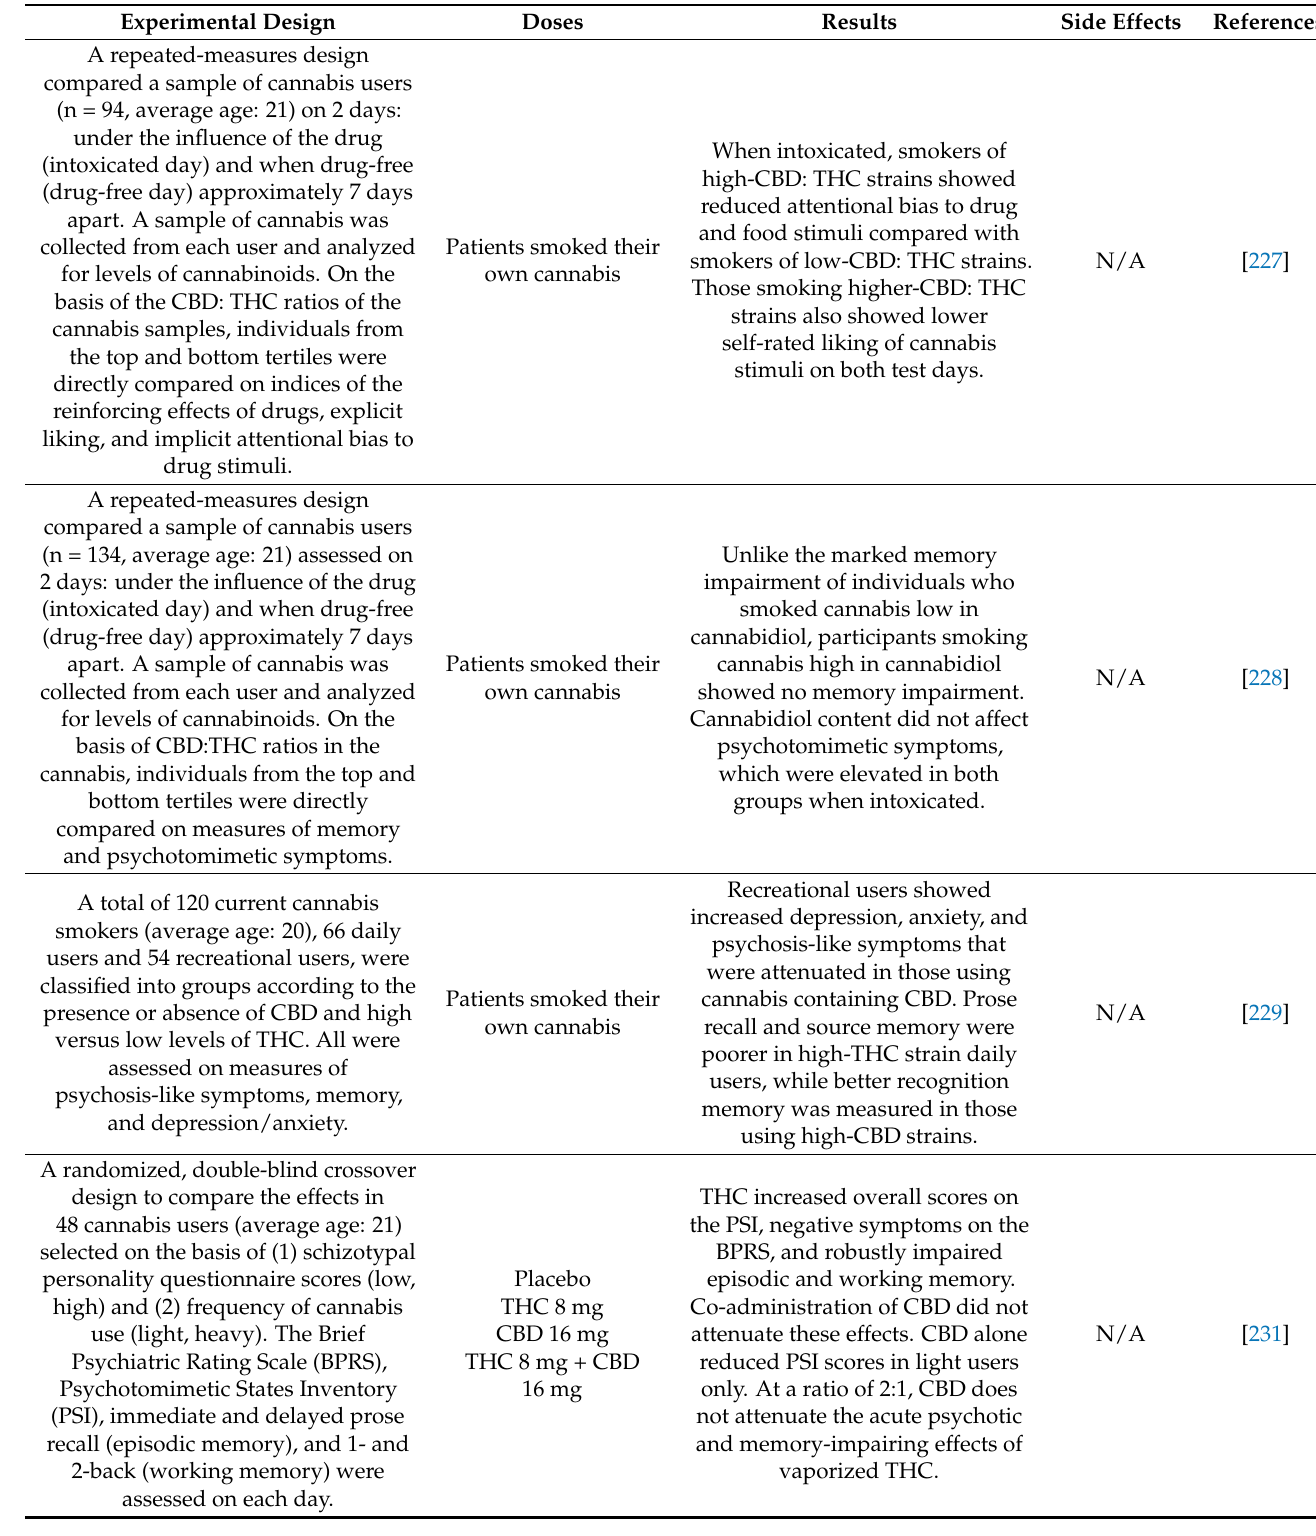
Table 2. Clinical trials evaluating the effects of THC and CBD on memory and attention and neuroin-